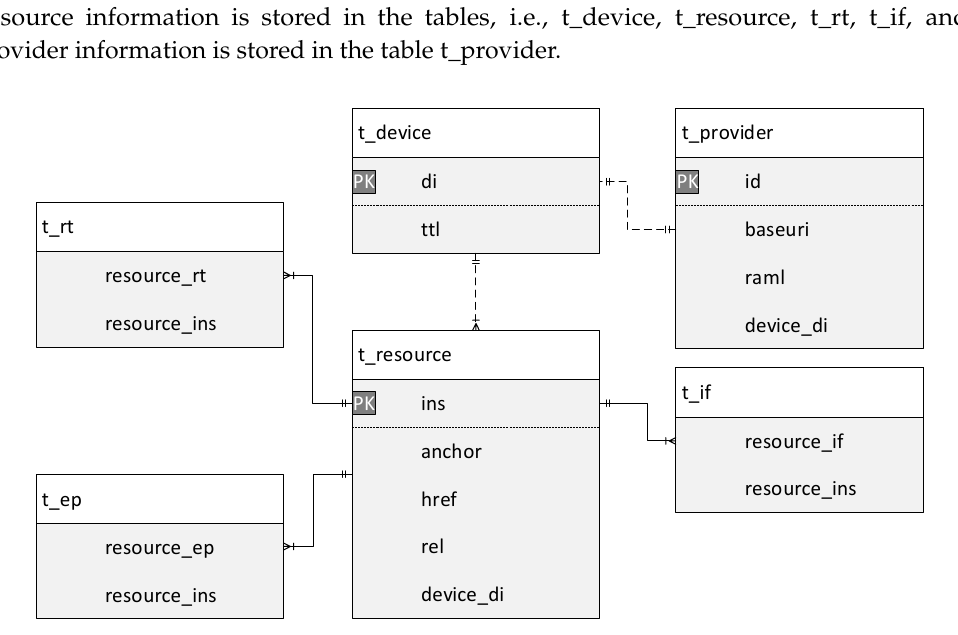
Figure 11. IoT proxy ER-diagram.